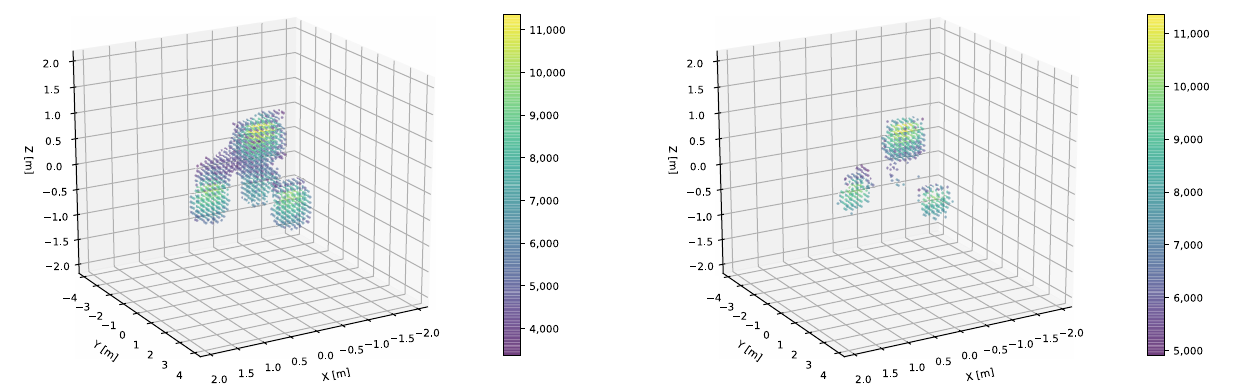
Figure 15. The 3D voxel map of multiple lead blocks reconstructed with the parameter set optimized for lead as shown in Table 3 ( left ) and the set for multiple lead blocks as shown in Table 6 ( right ). The color of the voxel point represents the combined voxel score s comb